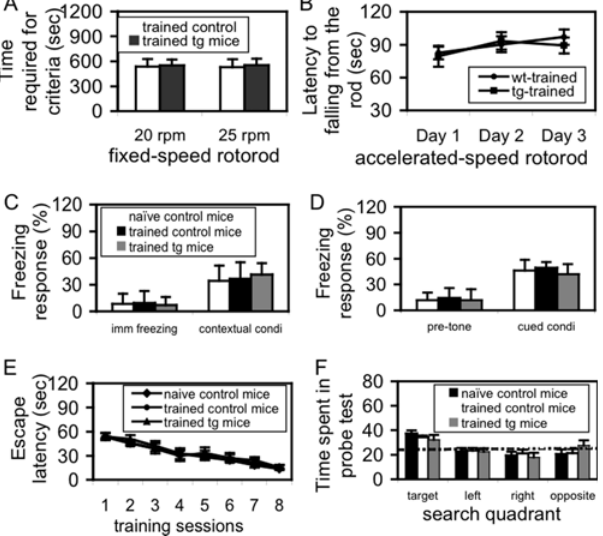
vehicle and the other two groups were treated with doxy (2 mg/ 100 ml) in dinking water from the start of VMT (P20) to the completion of rotorod tasking. Interestingly, after VMT, trained- tg-vehicle mice showed significantly enhanced performances in both 20 rpm and 25 rpm fixed-speed versions, compared to trained-control-vehicle, trained-control-doxy, and trained-tg-doxy mice (p , 0.01, respectively; Figure 7C). In addition, the perfor- mance in trained-tg-doxy mice was undistinguishable to the trained-control-vehicle or trained-control-doxy mice (Figure 7C), indicating that the enhanced effect is due to the transgene expression. In the accelerated-speed version with another set of mice, similar results were observed (Figure 7D). One-way ANOVA revealed a highly significant difference among these groups [F(3,40)= 24.72, p , 0.001]. Post-hoc analyses showed a significant difference between trained-tg-vehicle and either trained-control-vehicle or trained-control-doxy mice in each training session (p , 0.01, respectively) and between trained-tg- vehicle and trained-tg-doxy mice in each training session (p , 0.01, respectively). These results indicate that the expression of the NR2B transgene in the cerebellar granule cells significantly facilitates the effects of VMT on motor learning.